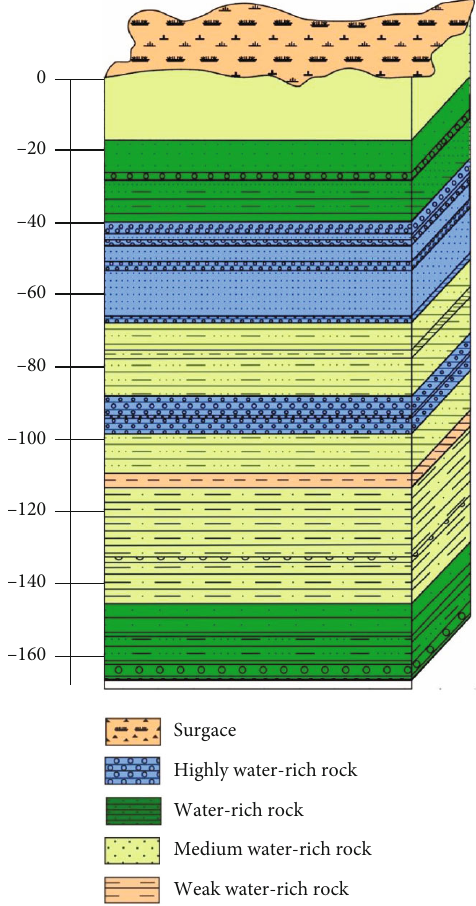
Figure 1: The hydrogeological structure in the study area